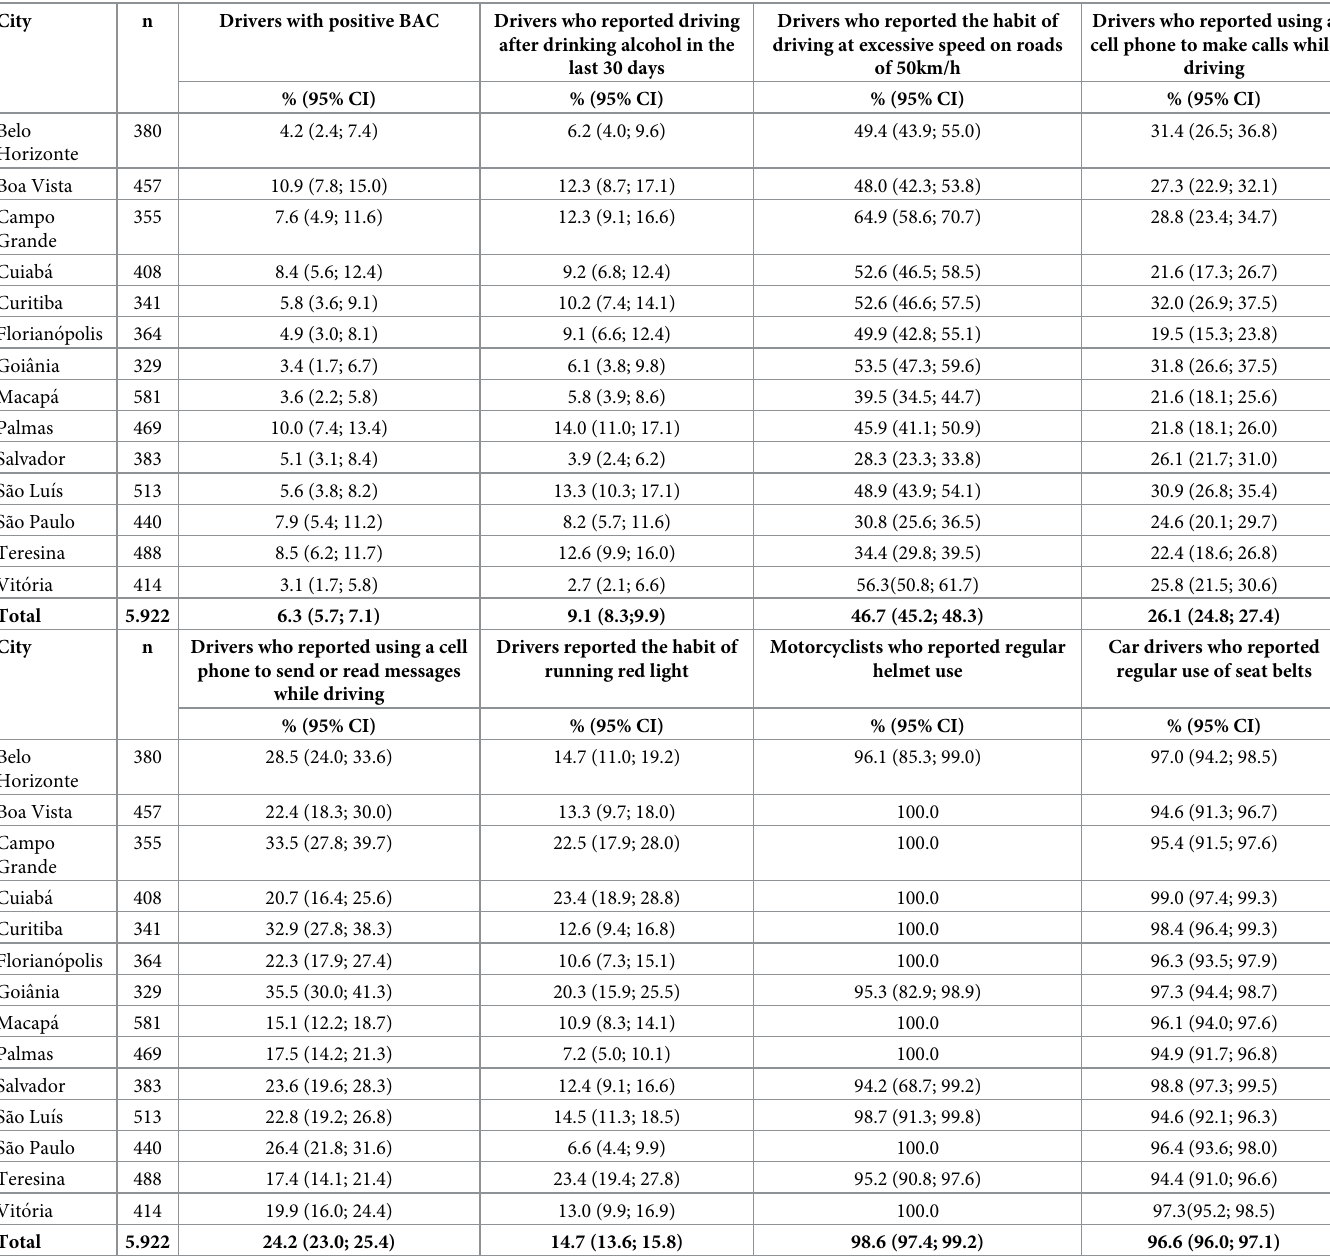
Table 1. Prevalence of risky and protective behaviors associated with traffic crashes in the 14 Brazilian capitals participating in the Life in Traffic Project, 2019. City n Drivers with positive BAC Drivers who reported driving